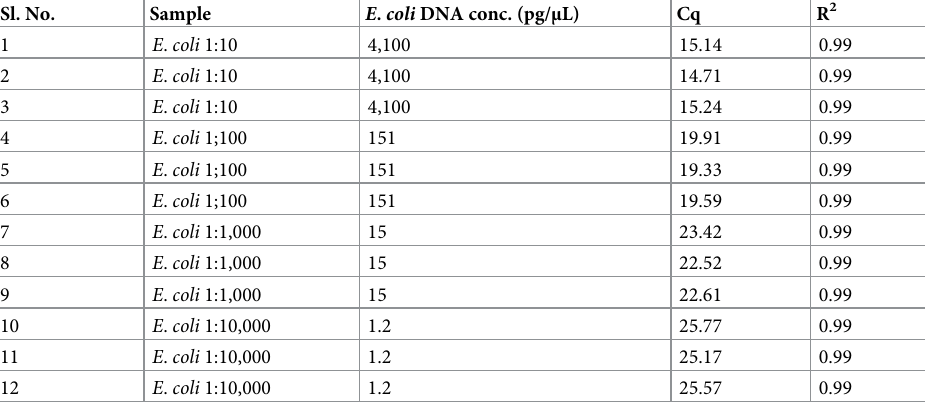
Table 2. Cq values of E . coli DNA serial dilutions. Sl.